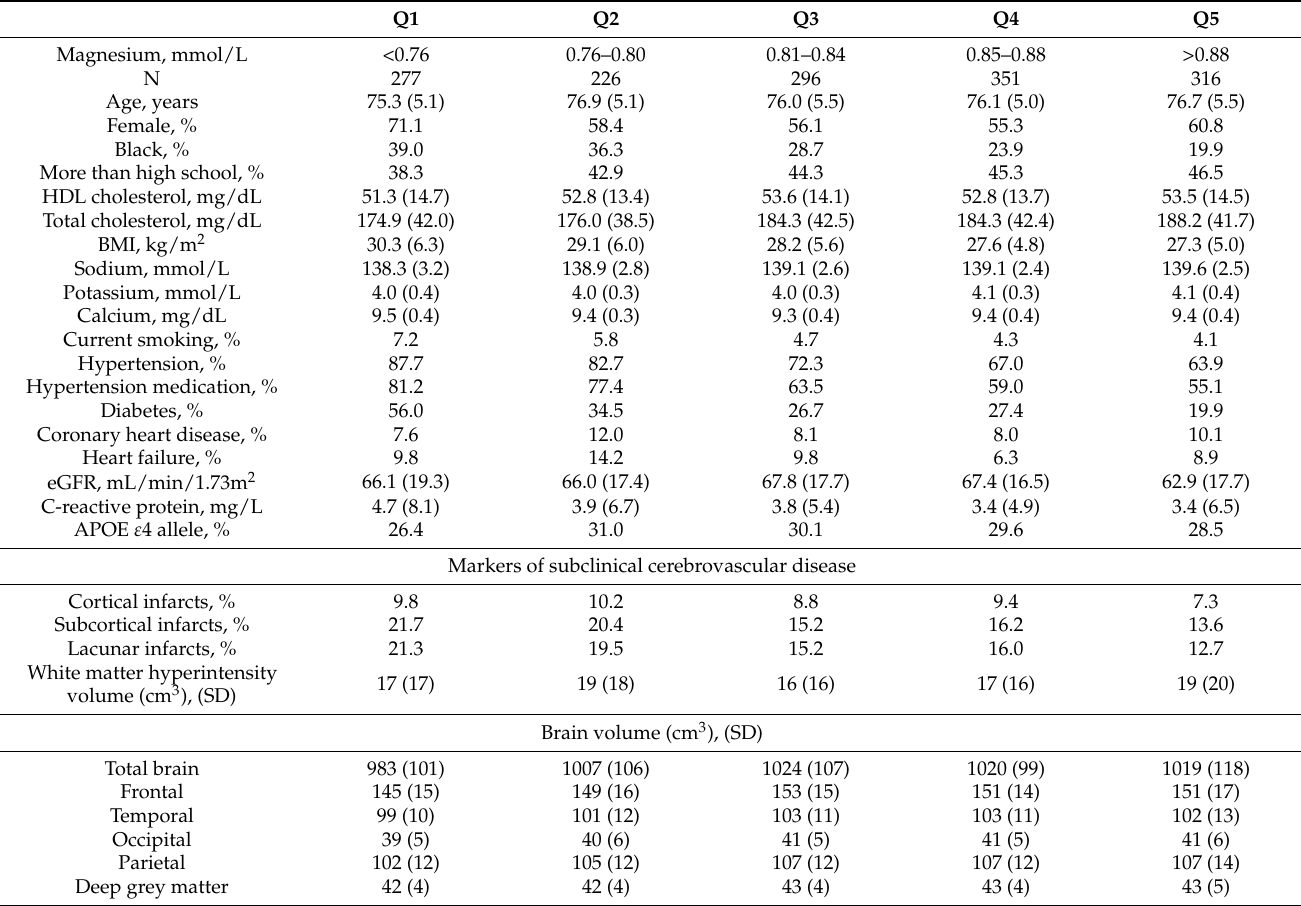
Table 1. Participant characteristics by magnesium quintiles, ARIC-NCS